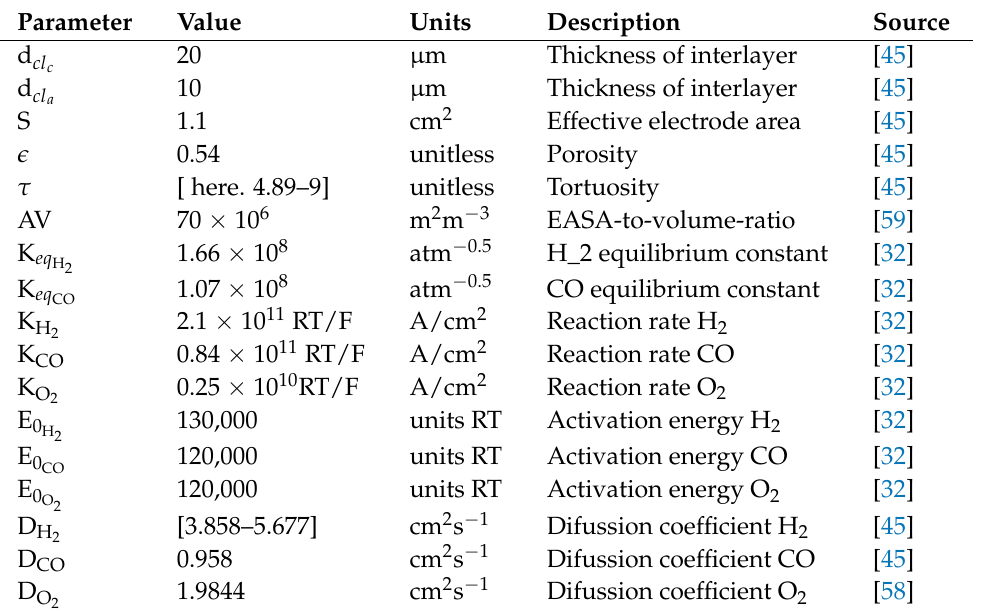
Table A1. List of model calibration parameters obtained from the